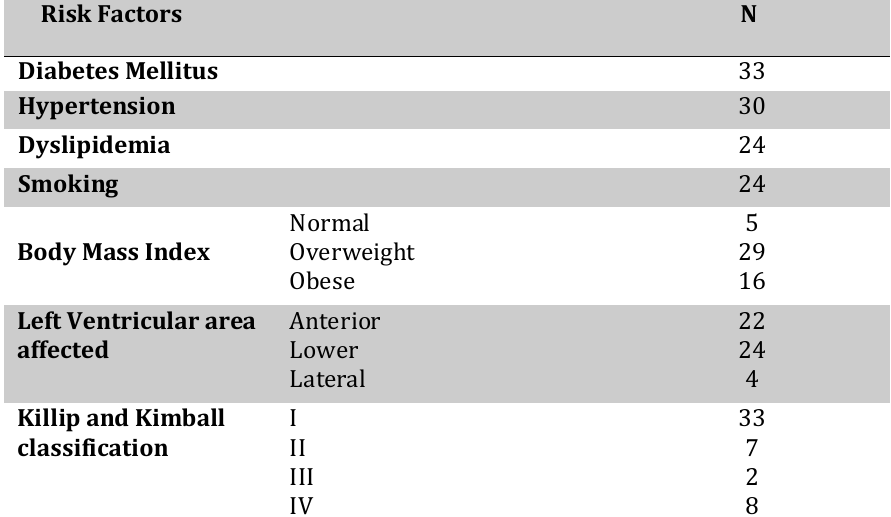
Table 1 . Cardiovascular disease risk factors and Killip Kimball stratification of